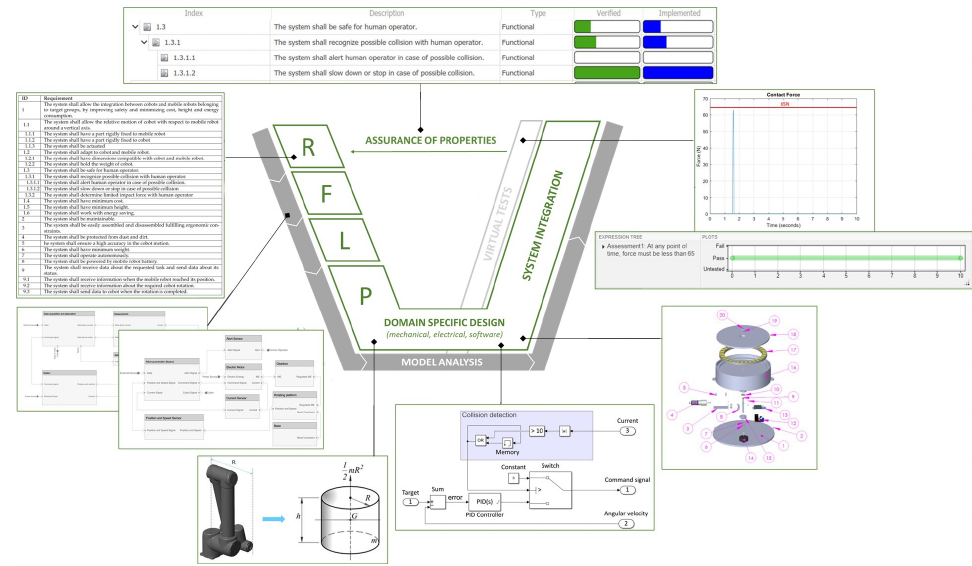
Figure 20. RFLP approach and main results.